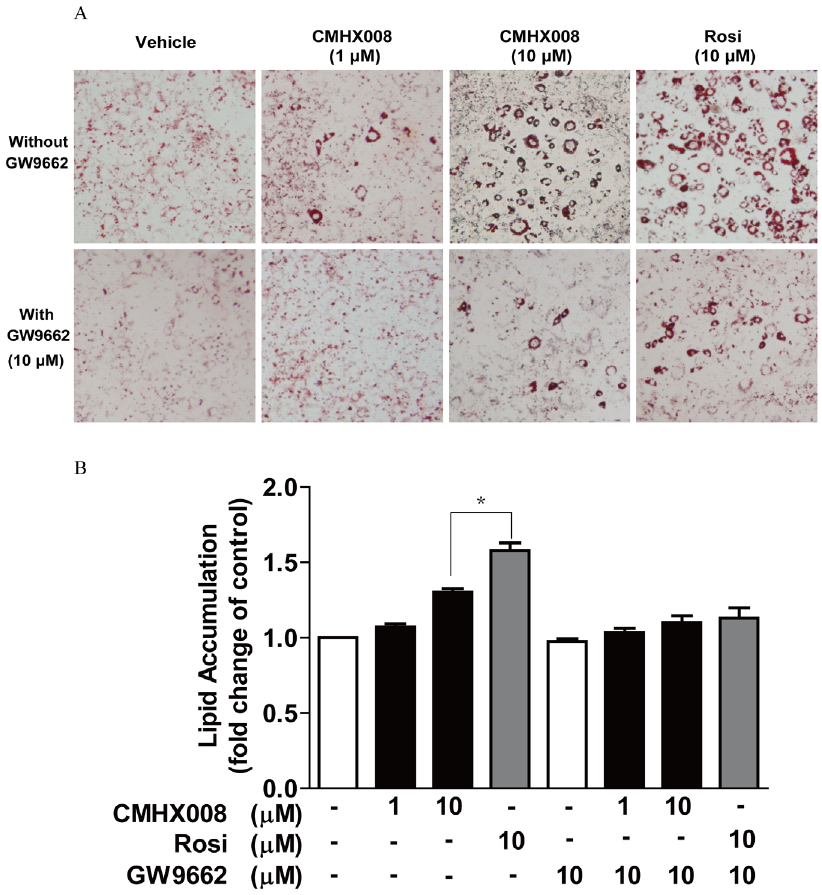
Figure 2. CMHX008 promotes 3T3-L1 preadipocytes differentiation and lipid accumulation. Post-confluent 3T3-L1 preadipocytes were incubated in differentiation medium for 2 days. The medium was changed to DMEM containing insulin and 10% FBS for another two days and then replaced again with fresh DMEM containing 10% FBS for another 3 days. Rosiglitazone and CMHX008, with or without GW9662, were administered at the initiation of differentiation and added with every medium change. At day 7, the differentiation cells were used for Oil Red O staining. A. The cells were fixed and stained with Oil Red O, and then stained adipocytes were photographed (100 6 ); B. Stained cells were eluted with isopropyl alcohol and quantified at 490 nm. Data are the means 6 S.E.M. from five experiments. *: P ,